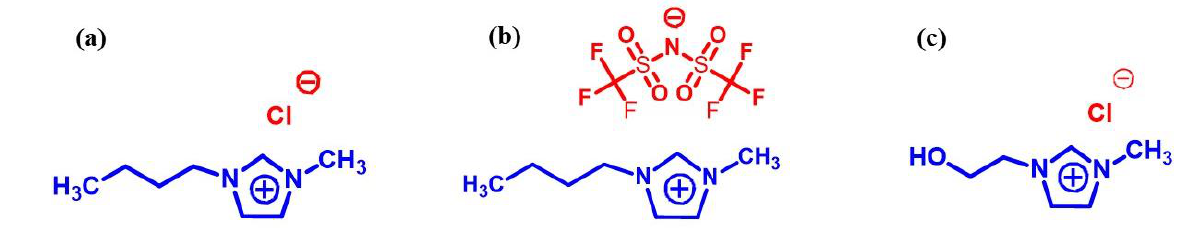
Figure 1. Chemical structures of IL studied: ( a ) C 4 MImCl, ( b ) C 4 MImNTf 2 , ( c ) C 2 OHMImCl.